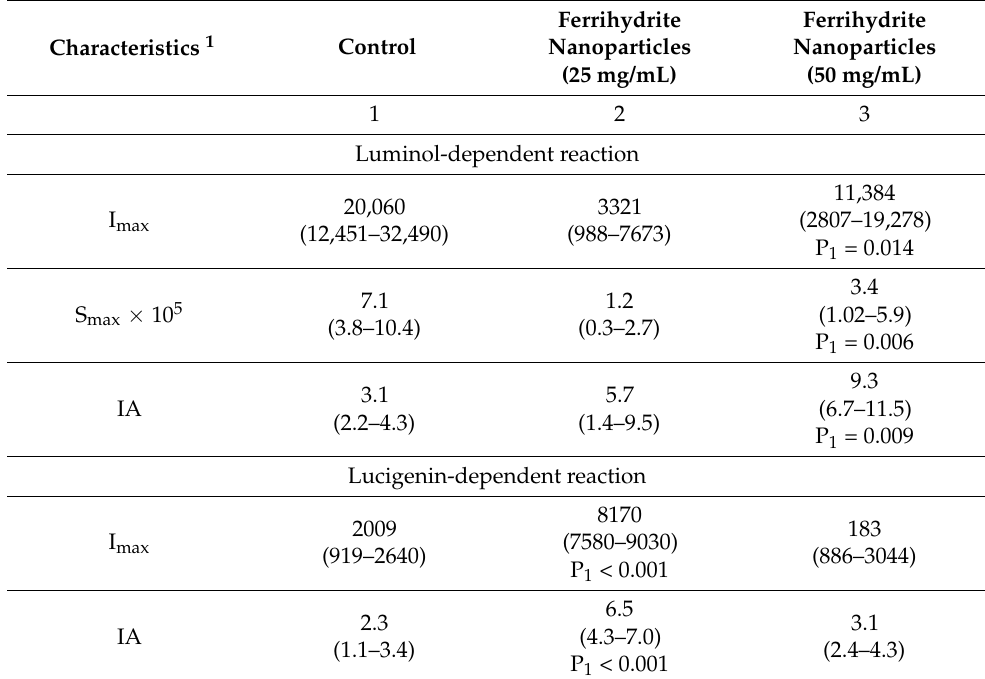
Table 1. Indicators of luminol-and lucigenin-dependent chemiluminescence of neutrophil granulo- cytes under the influence of different concentrations of ferrihydrite nanoparticles without incubation. Characteristics 1 Control